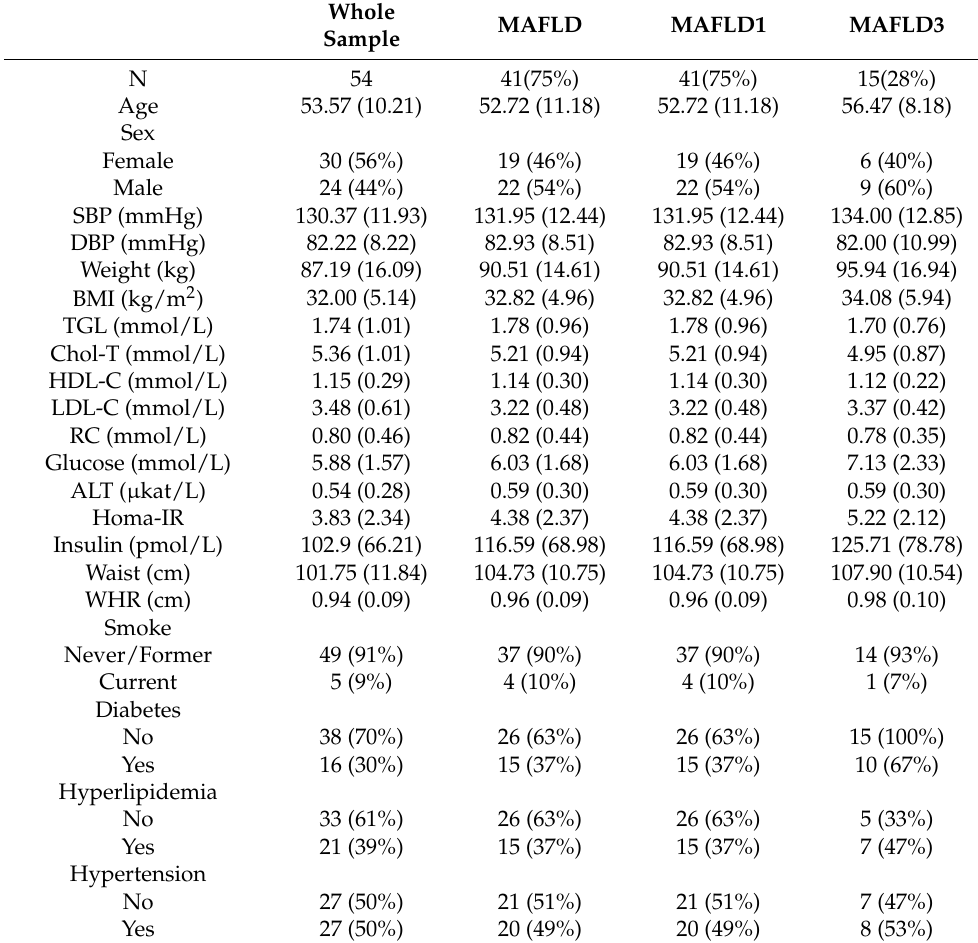
Table 2. Characteristics of participants with MAFLD and subtypes of